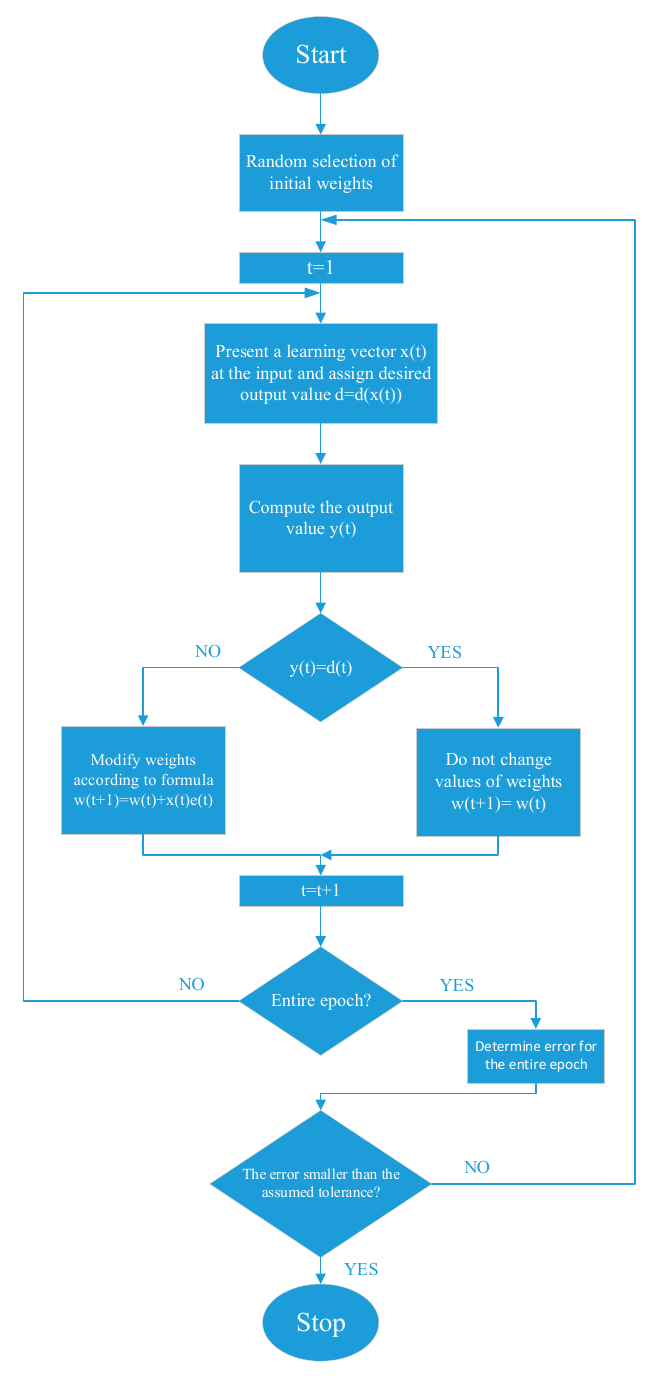
Figure 4. Perceptron learning flowchart.